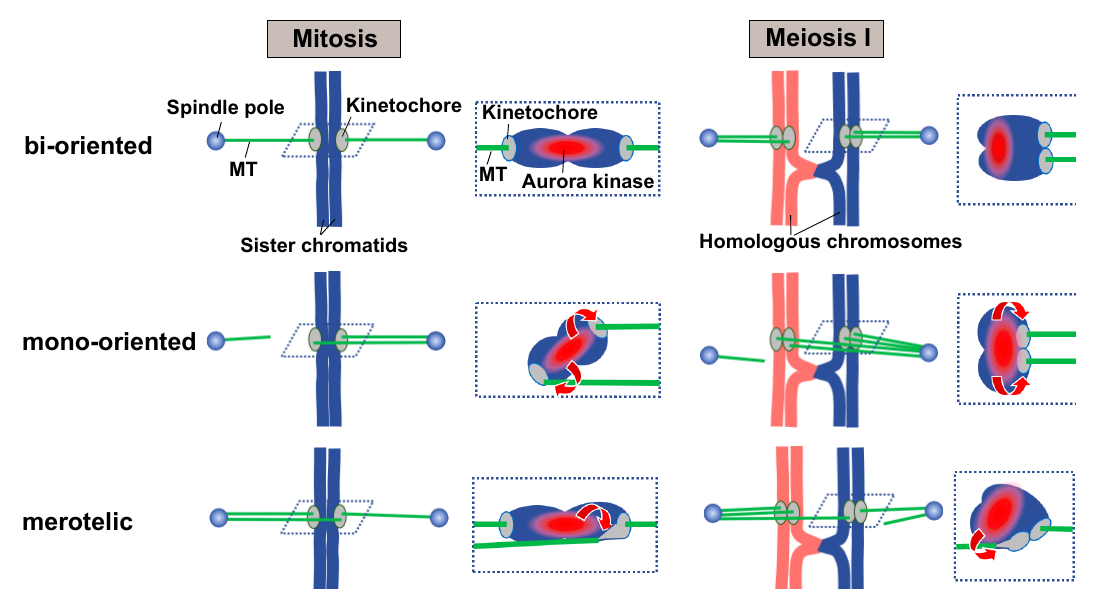
Figure 2. The current model of Aurora B–dependent elimination of improper attachments. Aurora B kinase is enriched at the inner centromere region, where sister chromatids associate with one another (red regions in dotted boxes). Bipolar attachment of sister chromatids in mitosis, or homologous chromosomes in meiosis I, causes stretching of centromeric chromatin and spatial separation of the kinetochore from the Aurora B–enriched region (bi-oriented). When sister chromatids or homologous chromosomes are attached to the same pole in mitosis or meiosis I, respectively, centromeric chromatin does not stretch, and the kinetochores are juxtaposed with the Aurora B–enriched region (mono-oriented). This juxtaposition causes phosphorylation of kinetochore components and elimination of attachments. When a single kinetochore is concomitantly attached to opposite poles in mitosis, the improper attachment site of the kinetochore approaches the Aurora B–enriched region (mitosis, merotelic). Similar spatial proximity of improper attachment sites to the Aurora B–enriched region occurs when associated sister kinetochores are attached to opposite poles at meiosis I (meiosis I, merotelic). Dotted boxes show kinetochore–MT interactions, and the predicted positions of kinetochores and the Aurora B–enriched region. Red arrows indicate Aurora B–dependent kinetochore phosphorylation. For simplicity, only one kMT attached to each single kinetochore is shown.